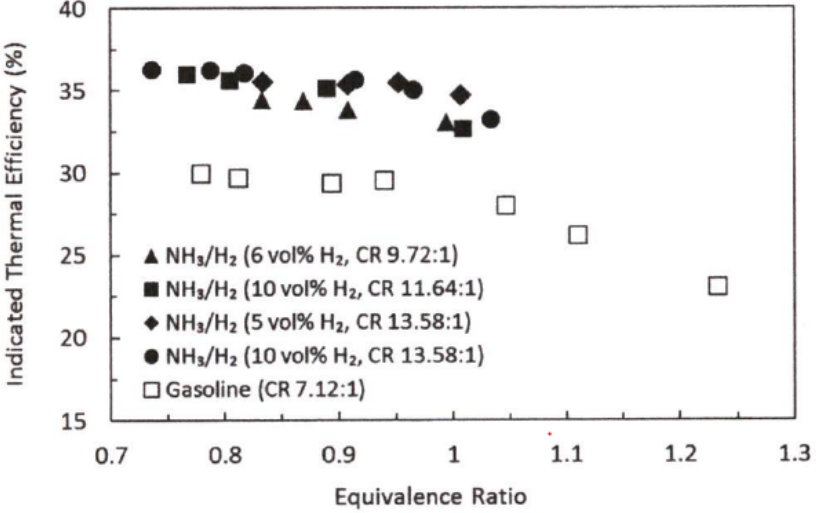
Figure 15. Thermal efficiency at different compression ratios and hydrogen-doping ratios.